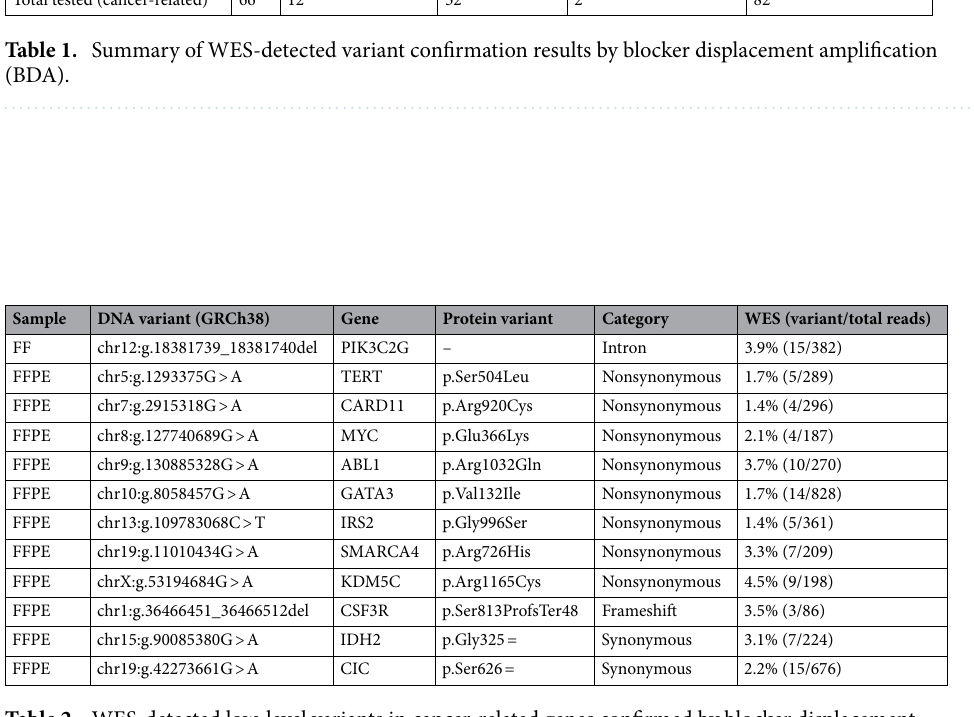
Table 1. Summary of WES-detected variant confirmation results by blocker displacement amplification (BDA).